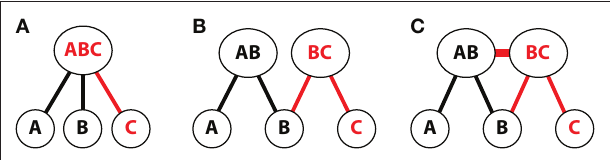
FIGURE 6 | Schematic depiction of alternative accounts of hippocampal representation in an associative inference task. Representations of overlapping events (AB, BC) are shown using a simplified two-layer architecture. The bottom layer contains units for each event element; the top layer contains hypothesized patterns of hippocampal representation. (A) Single integrated representation for overlapping events. According to this hypothesized structure, new, overlapping event elements (C) are encoded into an existing, reactivated memory (AB) to form a single composite representation for the two related associations. (B) Pattern separated representations of individual events. In this view, a new event (BC) with partial overlap to a previous memory (AB) would recruit a distinct hippocampal representation that preserves the details of each individual experience. Links between the common element (B) and each of the individual experiences could be used to mediate inference at encoding or retrieval. (C) Relational representation of overlapping events. In this framework, separate representations are maintained for overlapping events (AB, BC) and direct links between those events (at the level of the hippocampus) code their relationship to one